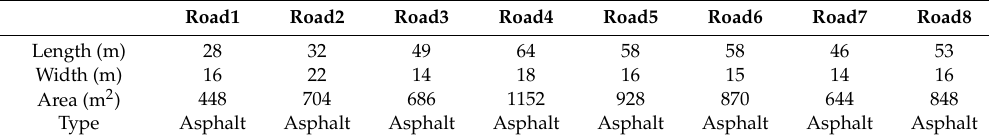
Table 2. Predefined parameters. GSD — ground sample distance.